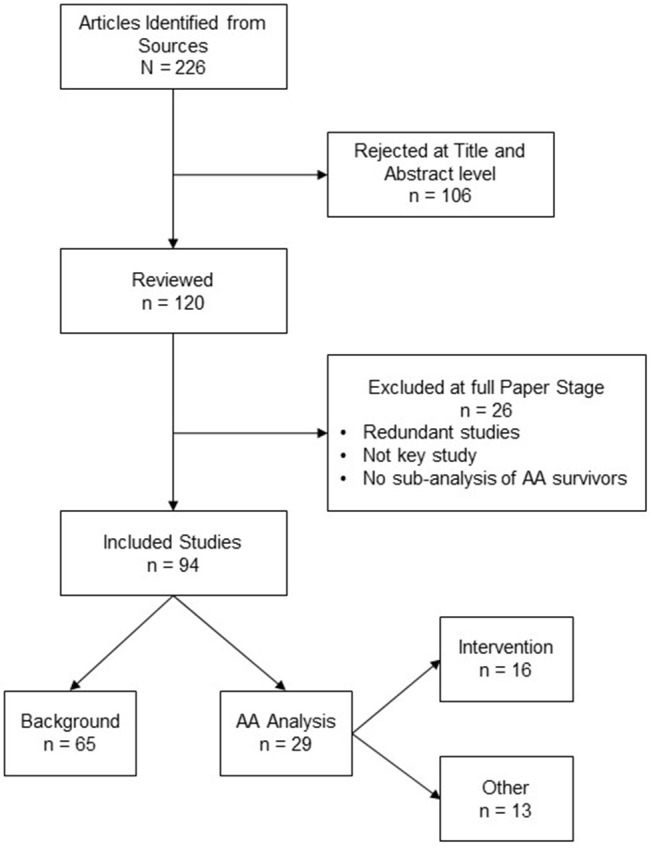
Diagram of the literature review and selection process.